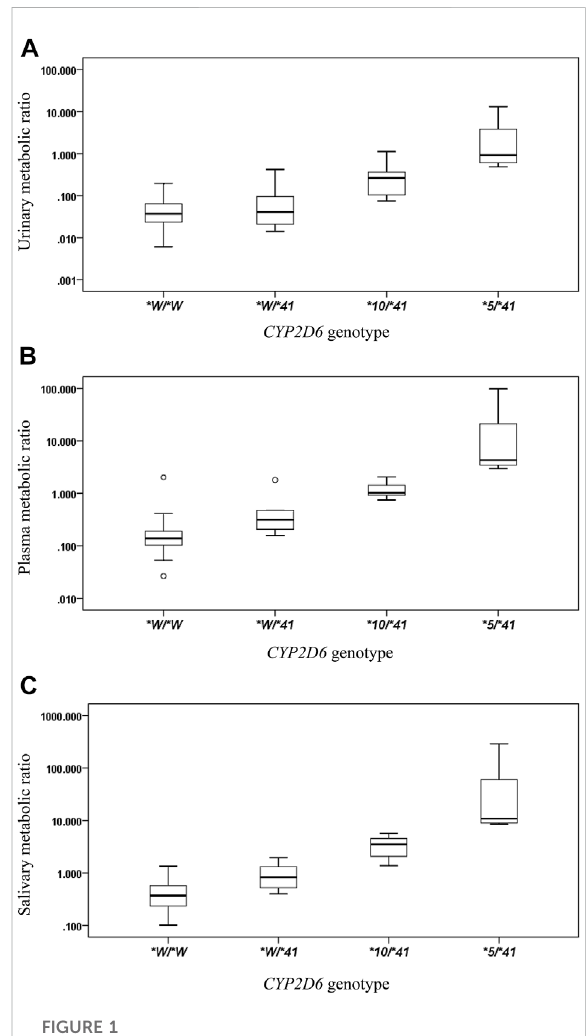
FIGURE 1 The box plots of metabolic ratio (MR) in the wild type ( CYP2D6*1 / *1 , *1 / *2 , *2 / *2 ) and the three CYP2D6*41 allele relevant genotypes in 87 healthy Chinese subjects. Allele *W represents CYP2D6*1 or *2 . The y -axis is logarithmic and the ratio is based on the MR DM/DX . (A) urinary MR; (B) plasma MR; (C) salivary MR. Box plot explanation: upper horizontal line of box, 75th percentile; lower horizontal line of box, 25th percentile; horizontal bar within box, median; upper horizontal bar outside box, 95th percentile; lower horizontal bar outside box, 5th percentile. Circles represent